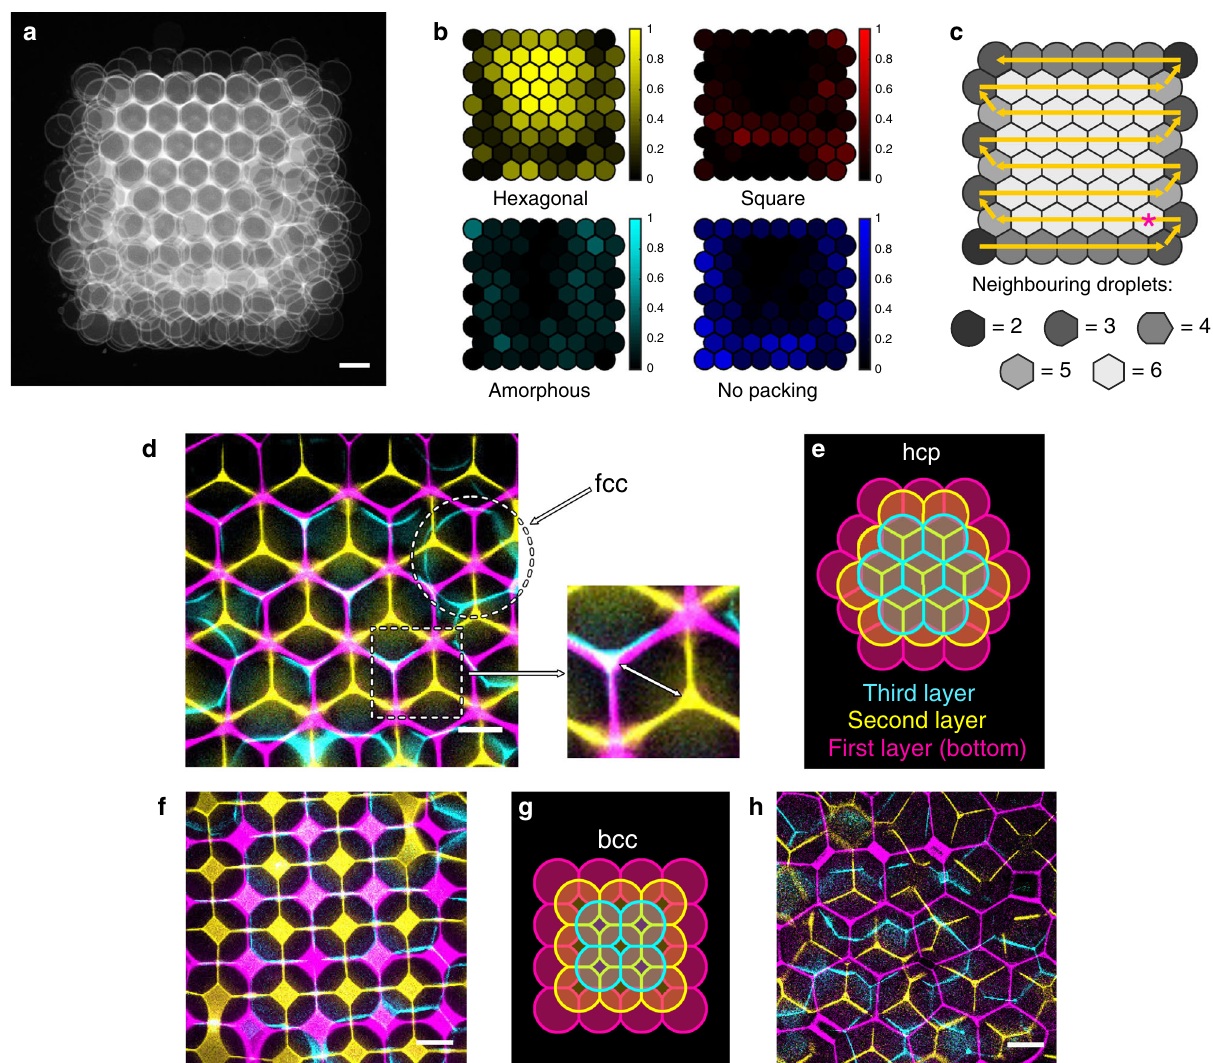
Fig. 4 Packing arrangements in the fi rst layer propagate to the upper layers. a Overlaid confocal microscopy images (co-registered) ( n = 5) of the fi rst layer of 3D-printed droplet networks, which had a hexagonal packing fraction of 0.50 ± 0.07 ( θ DIB = 36.3°, φ SIL = 0.55, x POPC = 0.13). b Heatmaps of the 2D localisation of different types of packing in the fi rst layer generated by analysing the images in a . The relative occurrence of each packing type (yellow, red, cyan and blue represent hexagonal, square, amorphous and no packing, respectively) is binned onto an idealised printing map of the fi rst layer (see “ Methods ” ). c A diagram of the droplet printing path in the fi rst layer (yellow arrows), with droplet shapes corresponding to the number of neighbouring droplets. The star indicates the fi rst droplet in the printing path to become surrounded by six neighbouring droplets. d Overlaid confocal microscopy images of horizontal cross-sections of the fi rst (magenta), second (yellow) and third (cyan) layers of a single 3D-printed droplet network ( φ SIL = 0.55, x POPC = 0.13). The zoomed-in panel shows that layers 1 and 3 are in alignment, while layer 2 is offset by a distance equal to the circumradius of the unit hexagon (marked by the white arrow). The circle marks a face-centred cubic defect. e A diagram of hexagonal close packing corresponding to d . f Overlaid confocal microscopy images of the fi rst (magenta), second (yellow) and third (cyan) layers of a single 3D-printed droplet network derived from a patch of square packing in the fi rst layer ( φ SIL = 0.50, x POPC = 0.27). Similarly to d , the overlay shows that layer 2 is offset with respect to layers 1 and 3. g , A diagram of body-centred cubic (bcc) packing corresponding to f . h Overlaid confocal microscopy images of the fi rst (magenta), second (yellow), and third (cyan) layers of a single 3D-printed droplet network derived from an amorphous patch in the fi rst layer ( φ SIL = 0.65, x POPC = 0.33). No regular lattice is formed between the layers. Scale bars are 100 µ m for a ; and 50 µ m for d , f , and h . d , f and h are from three different droplet 3D replicas of tessellated droplet shapes con fi rm hcp . To con- fi rm the hcp of droplets in 3D-printed networks, we imaged the space- fi lling shapes adopted by the droplets within a network. The fi nal shape of a droplet is determined by θ DIB , and by the number of surrounding droplets and their locations. Optical